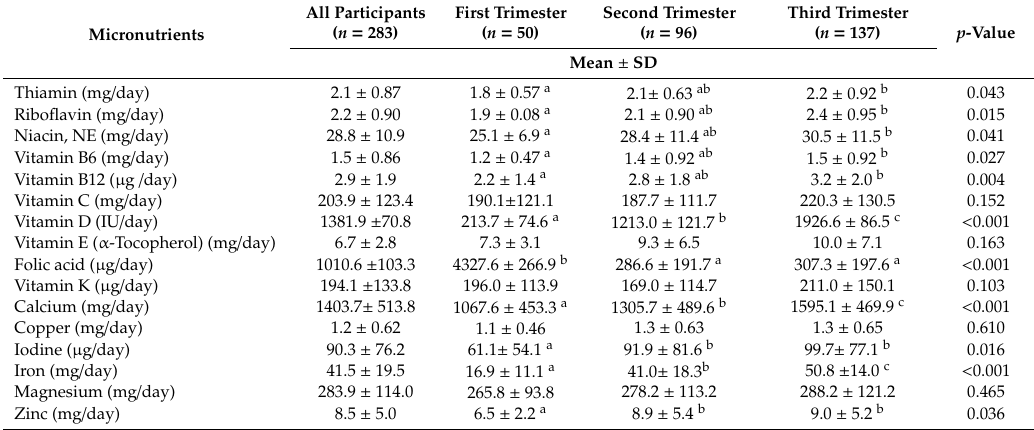
Table 6. The mean daily intake of total micronutrients (including food sources and supplements) obtained from a validated food frequency questionnaire administered to 283 pregnant Jordanian